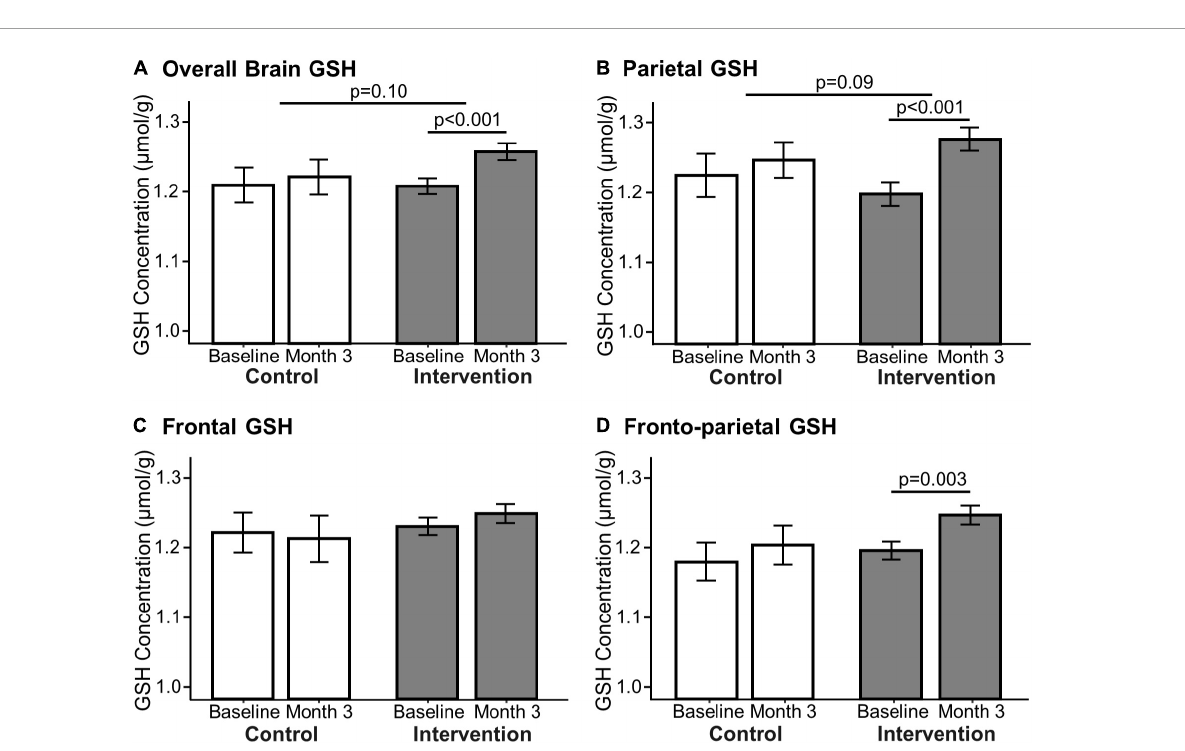
FIGURE4 Effect of 3-month milk intervention on brain GSH concentrations. GSH concentrations in the overall brain ( A : p < 0.001), parietal ( B : p < 0.001), and fronto-parietal ( D: p = 0.003) regions increased within the intervention group from baseline to the end of the study determined by paired t -test. There was no change in GSH concentration in the frontal region (C) nor in the control group between baseline and Month 3. Linear mixed models comparing changes in GSH concentration between the two groups indicated that the intervention group had a trending increase in overall ( p = 0.10) and parietal ( p = 0.09) GSH concentrations compared to the control